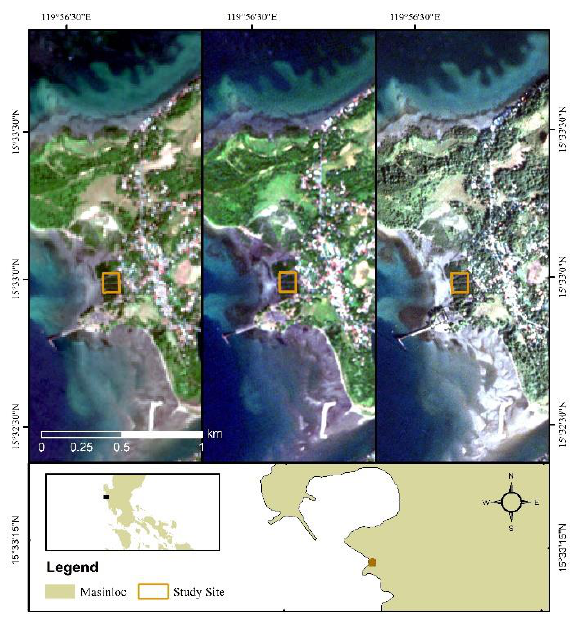
Figure 1. Location of the study site in Masinloc, Zambales, Philippines. A subset area is shown in RGB composite: Sentinel-2 (left), RapidEye (center) and PlanetScope